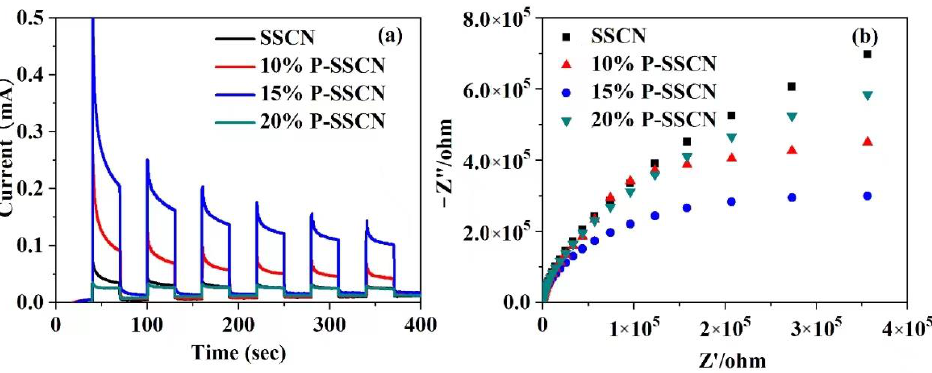
Figure 7. ( a ) Photocurrent response curves and ( b ) electrochemical impedance spectroscopy of SSCN, 10% P-SSCN, 15% P-SSCN, and 20% P-SSCN under visible light